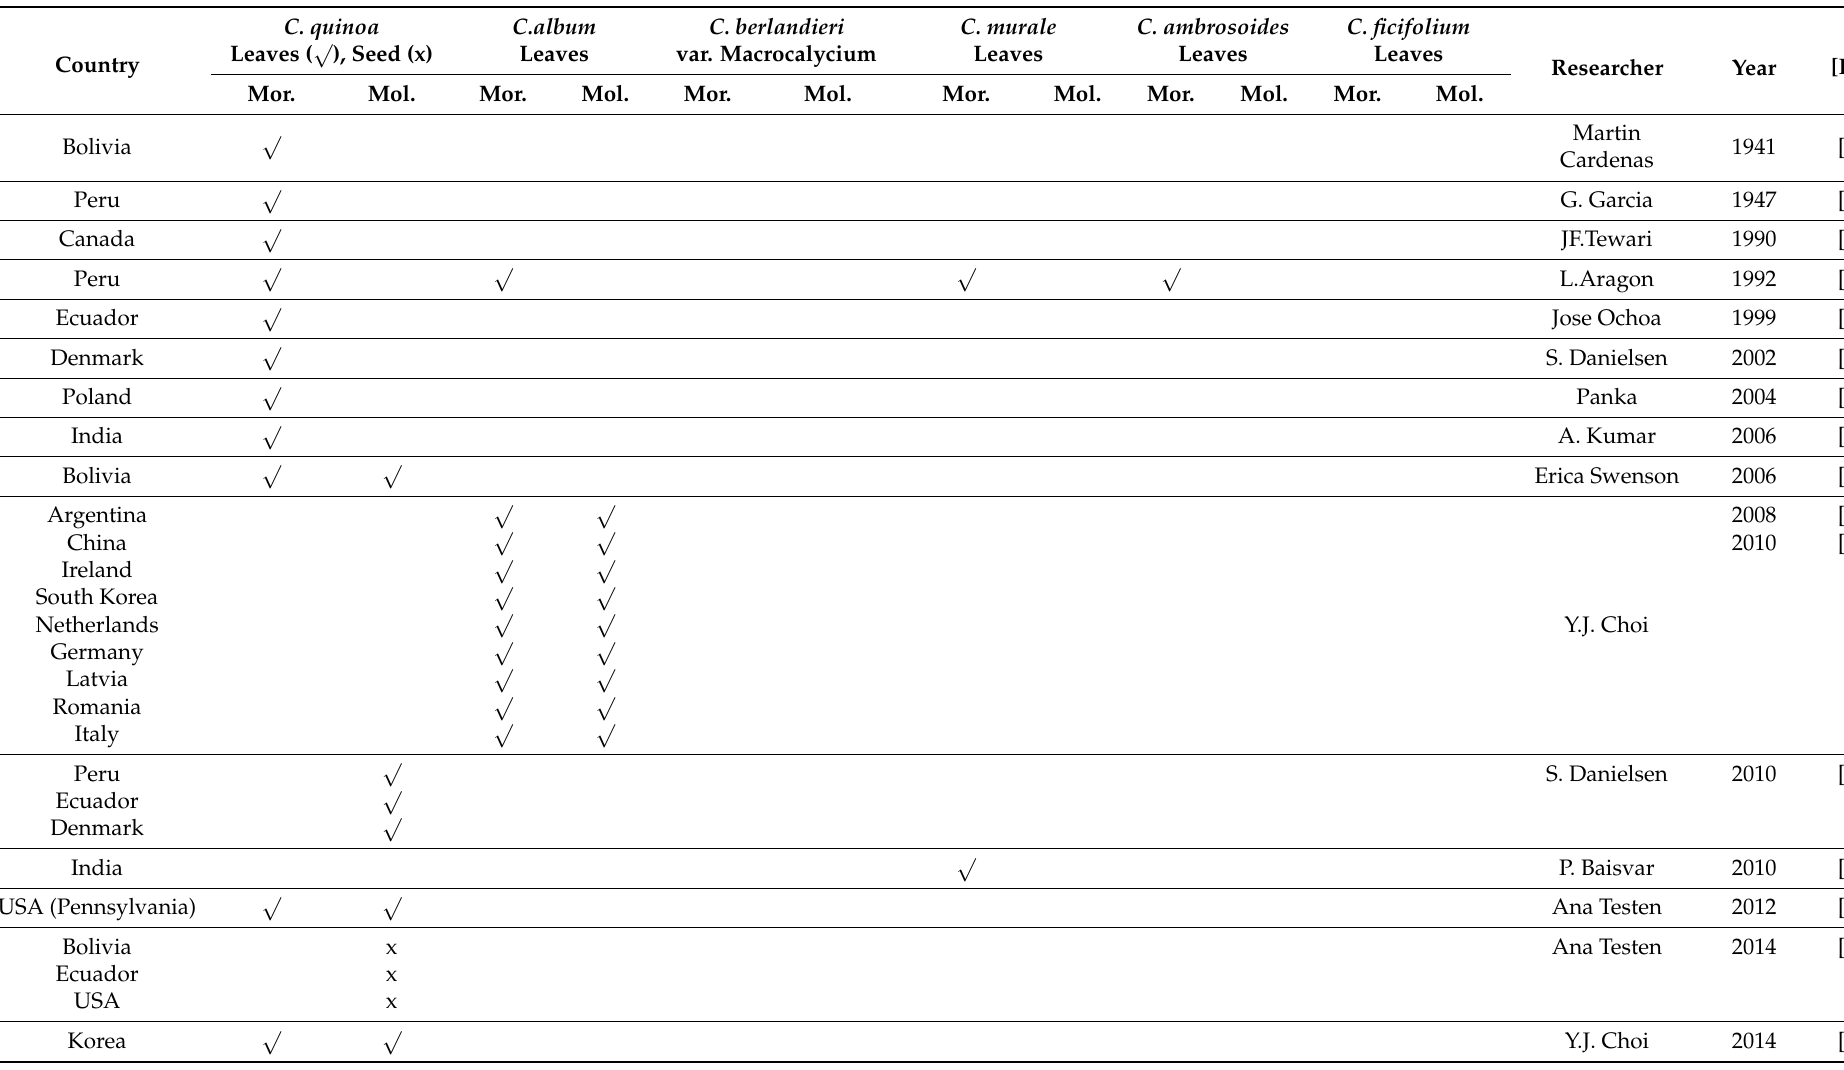
Table 2. Documented reports for downy mildew on C. quinoa and weedy